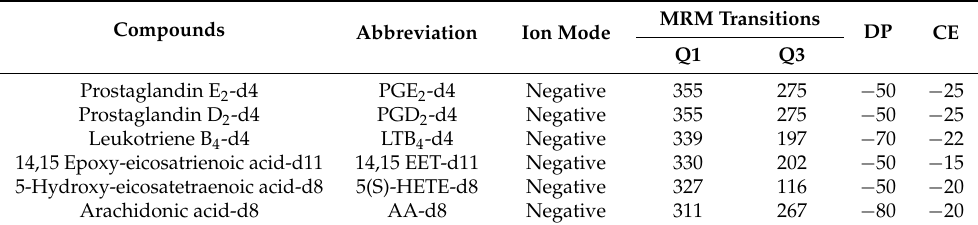
Table 1. Optimized multiple-reaction monitoring (MRM) conditions for eicosanoid